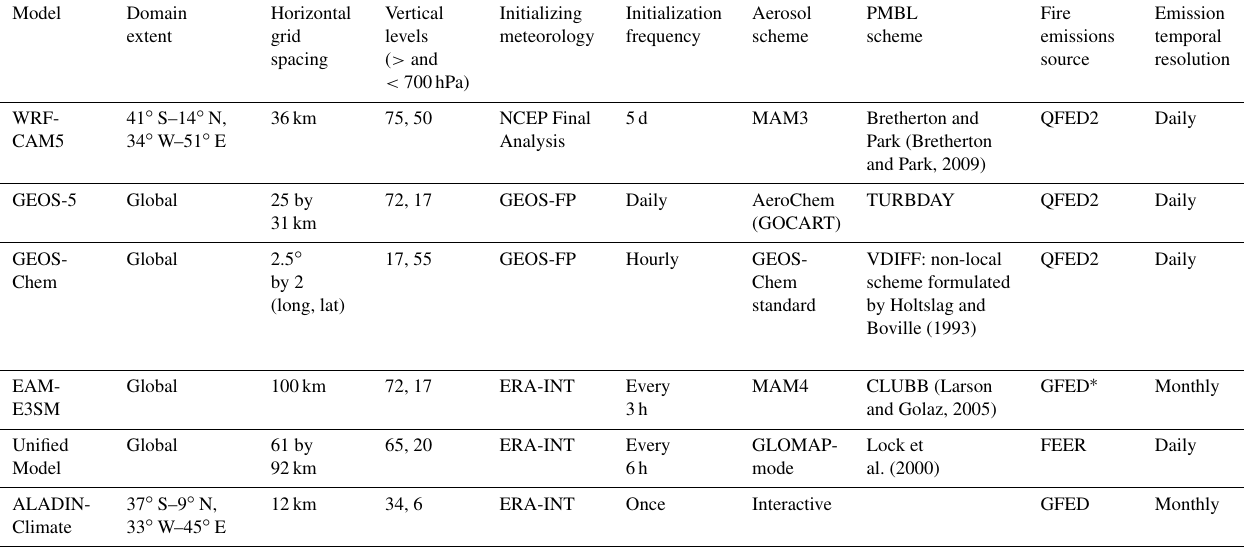
Table 2. Model specifications.